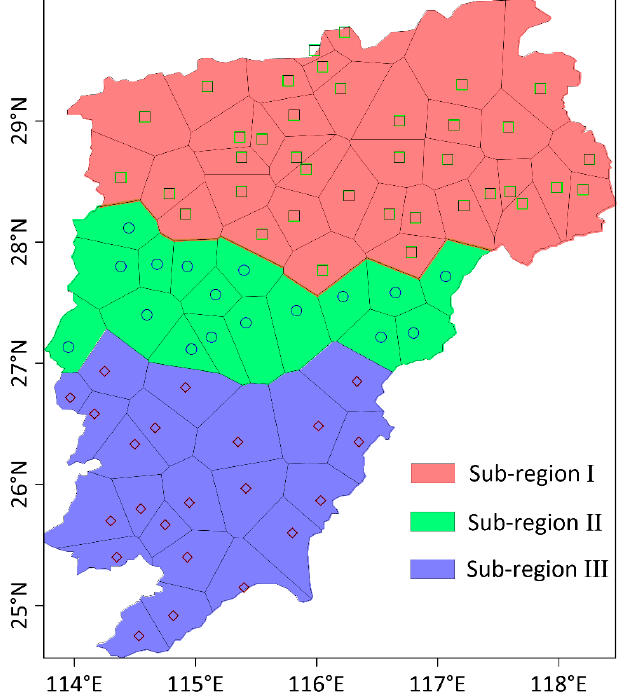
Figure 4. Climatic division of summer precipitation in the PYLB and Thiessen polygon regimes of sub-regions. of